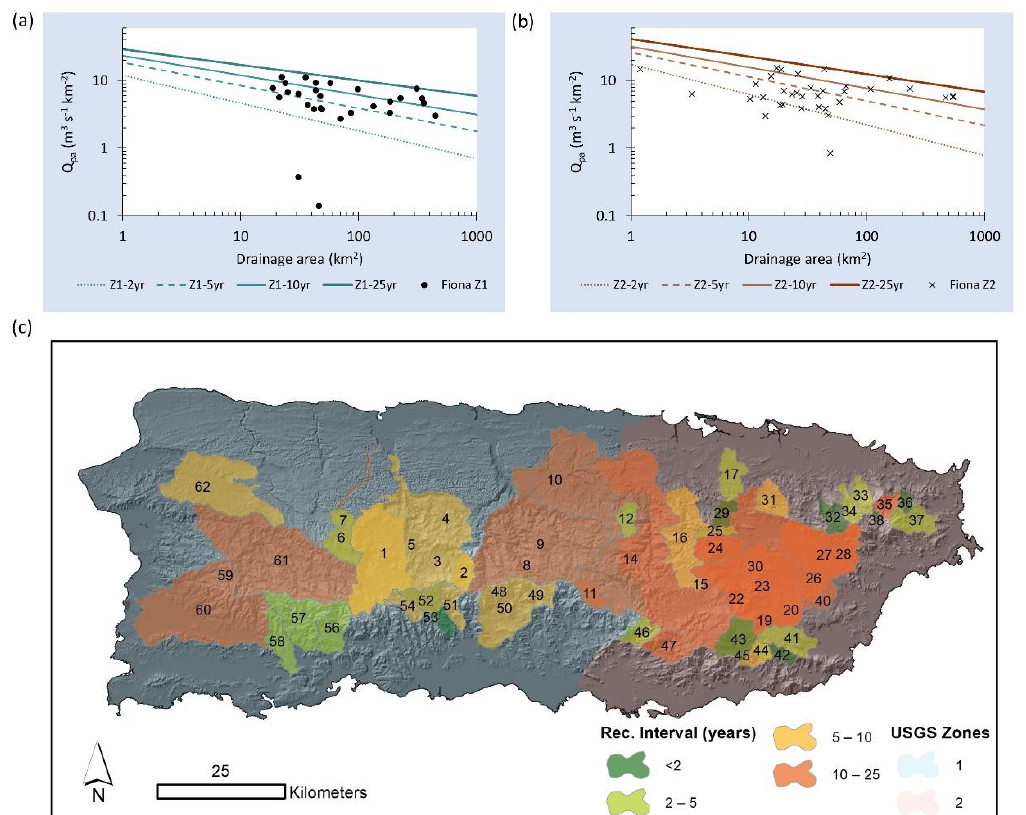
Figure 8. Watershed-by-watershed evaluation of Hurricane Fiona’s area-normalized instantaneous peak flows (Q pa ) relative to estimated recurrence intervals [42]. ( a ) Drainage area versus Hurricane Fiona Q pa values for watersheds in Puerto Rico’ss Zone 1 (western) relative to estimated recurrence intervals (Equations (8a)–(8d)). ( b ) Drainage area versus Hurricane Fiona Q pa values for watersheds in Puerto Rico’s Zone 2 (eastern) relative to estimated recurrence intervals (Equations (9a)–(9d)). ( c ) Watershed-by-watershed distribution of Hurricane Fiona’s Q pa values with respect to estimated recurrence interval. Table 2. Summary of recurrence interval analyses for Hurricane Fiona’s instantaneous peak flow observations for Puerto Rico overall and for Zones 1 and 2. Number of Stations Number of Stations Proportion Rec. Int. Zone